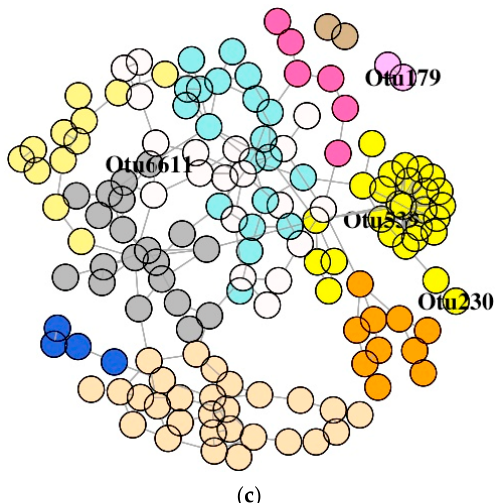
Figure 8. Association network graphs of the significantly abundant OTUs of Atlantic salmon. Mid intestine mucus bacterial networks of the control ( a ), florfenicol-fed ( b ), and oxolinic-acid-fed ( c ) fish. Nodes represent OTUs and specific colors of the modules reveal the memberships of the significantly abundant OTUs.